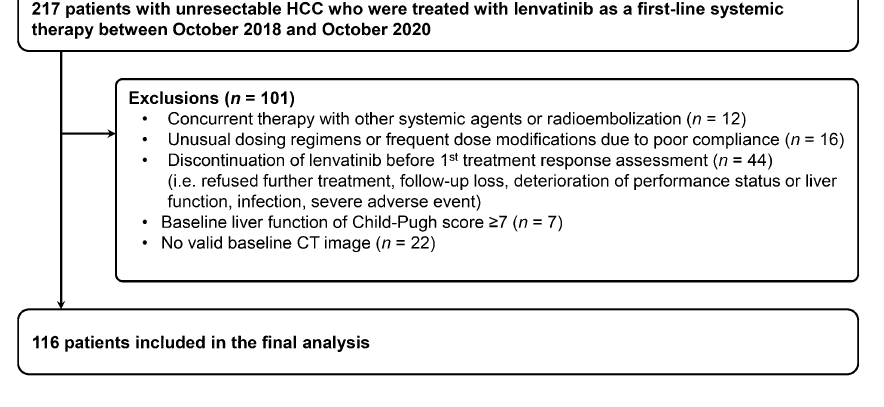
Figure 1. Patient